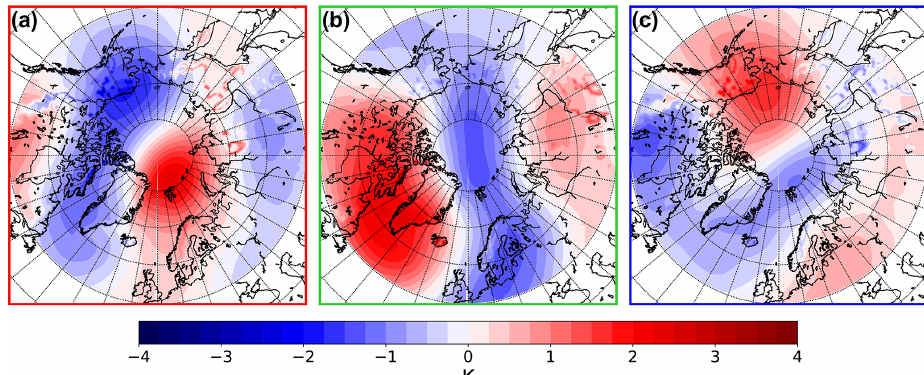
Figure 4. Composite of vertically averaged (surface to 200hPa) potential temperature minus the mean of the winter mean period from 1979 to 2016.